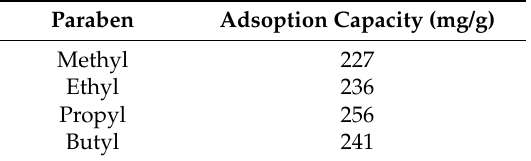
Table 2. Adsorption capacity (mg/g) of chitosan coated activated carbon.